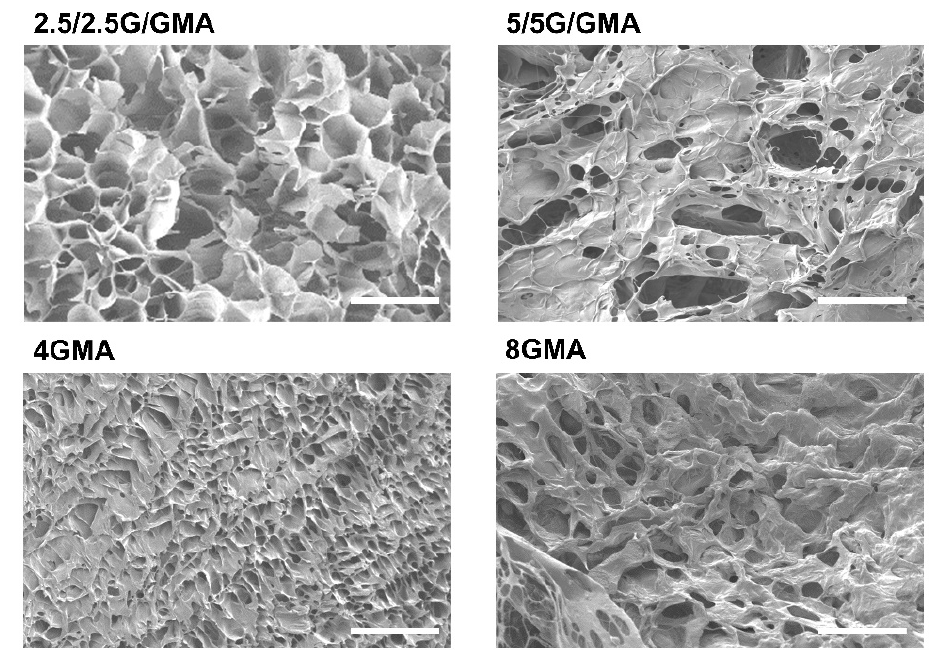
Figure 2. Micrographs of lyophilized bioinks obtained by SEM analysis (Magnification of 500 × and 50 µ m scale).